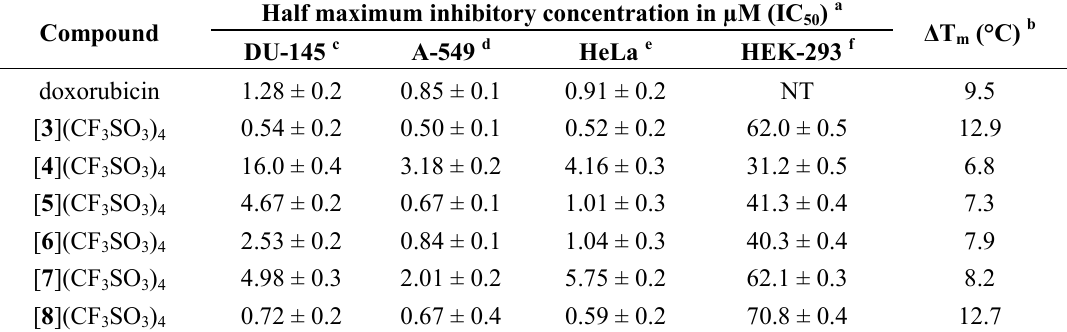
Table 1. IC cancer cell lines (DU-145, A-549, HeLa) and on the noncancerous cell line HEK-293, as well as DNA melting temperatures ( Δ T